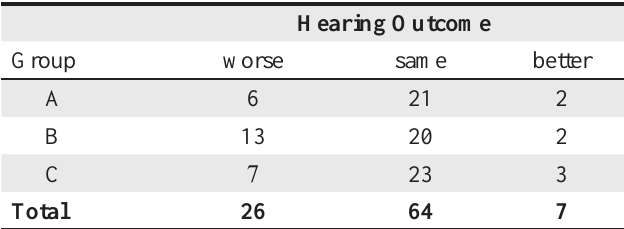
Table 2 : Hearing outcome